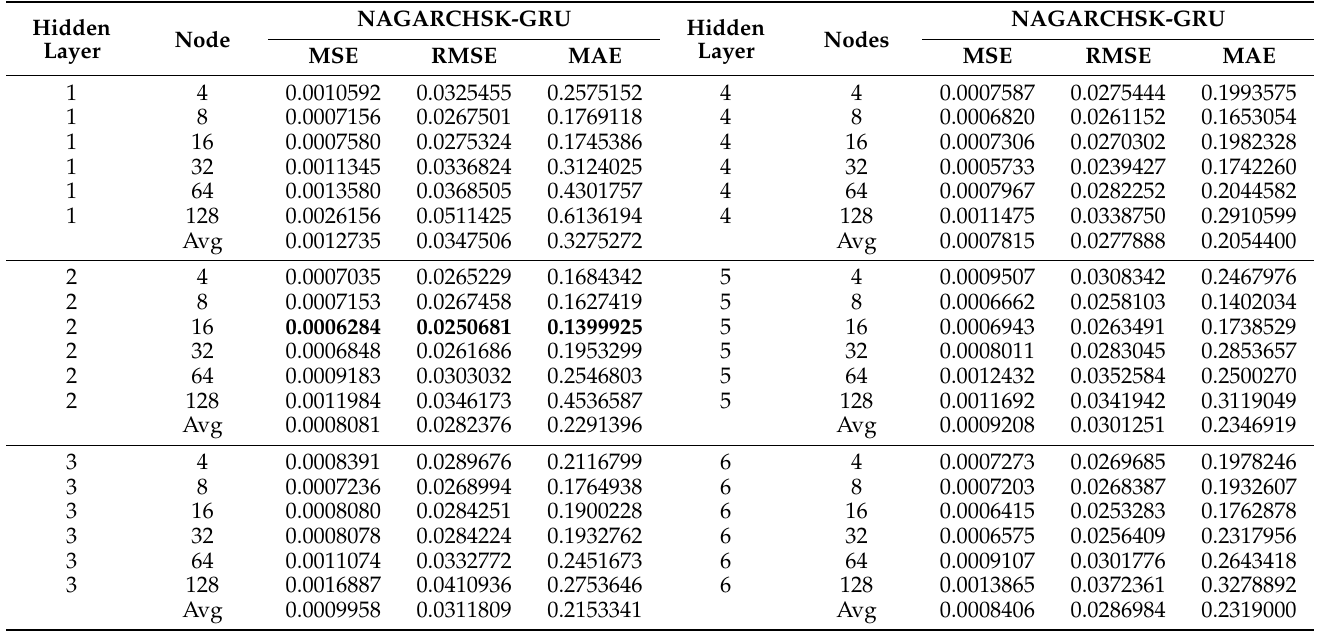
Table 2. Performance of the proposed NAGARCHSK-GRU: hidden layers and hidden